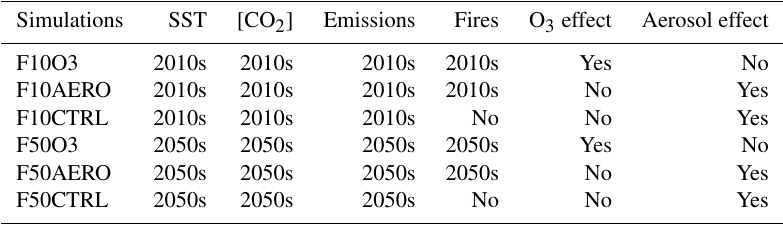
Table 1. Online simulations with ModelE2-YIBs climate model. ∗